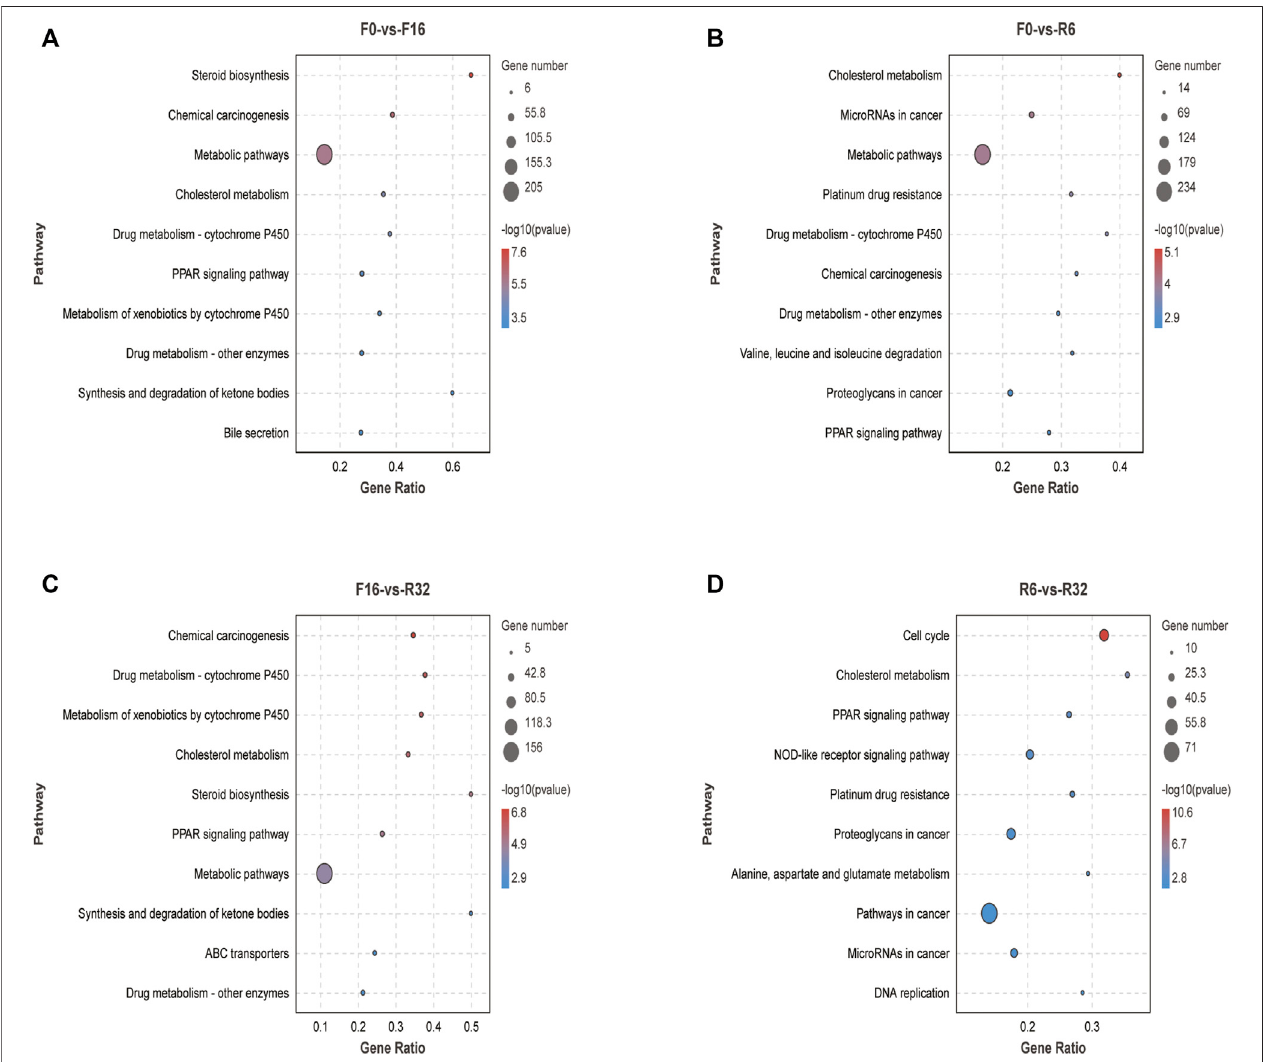
FIGURE 2 | KEGG enrichment analysis of different genes in comparison groups during IM. (A) F0-vs-F16. (B) F0-vs-R6. (C) F16-vs-R32. (D) R6-vs-R32.